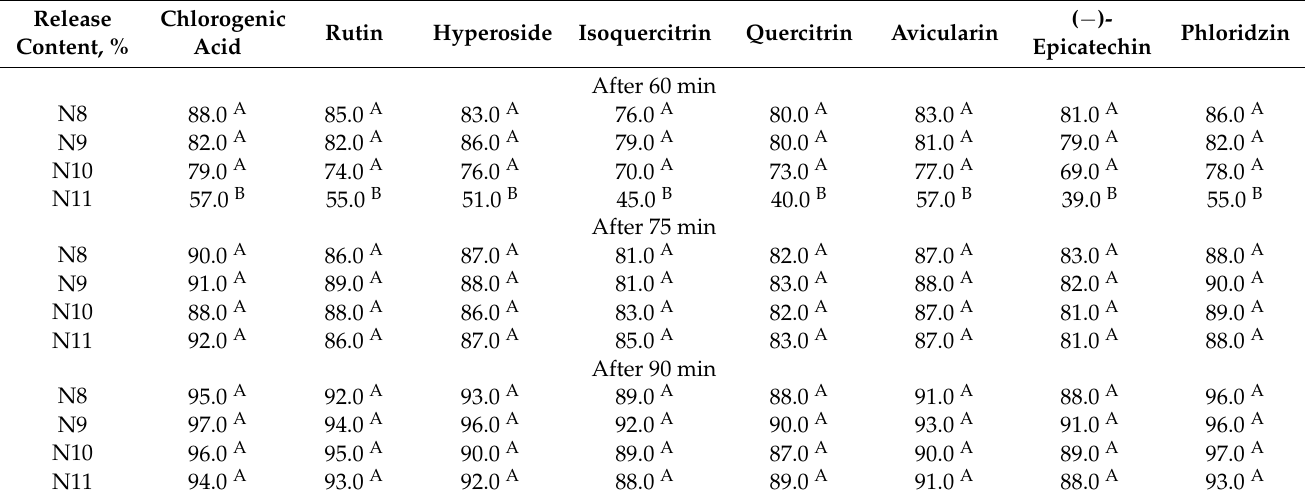
Table 4. Results of the dissolution test. Released content of the individual phenolic compounds after 60, 75, 90 min. The means followed by different letters in the columns are significantly different at p <